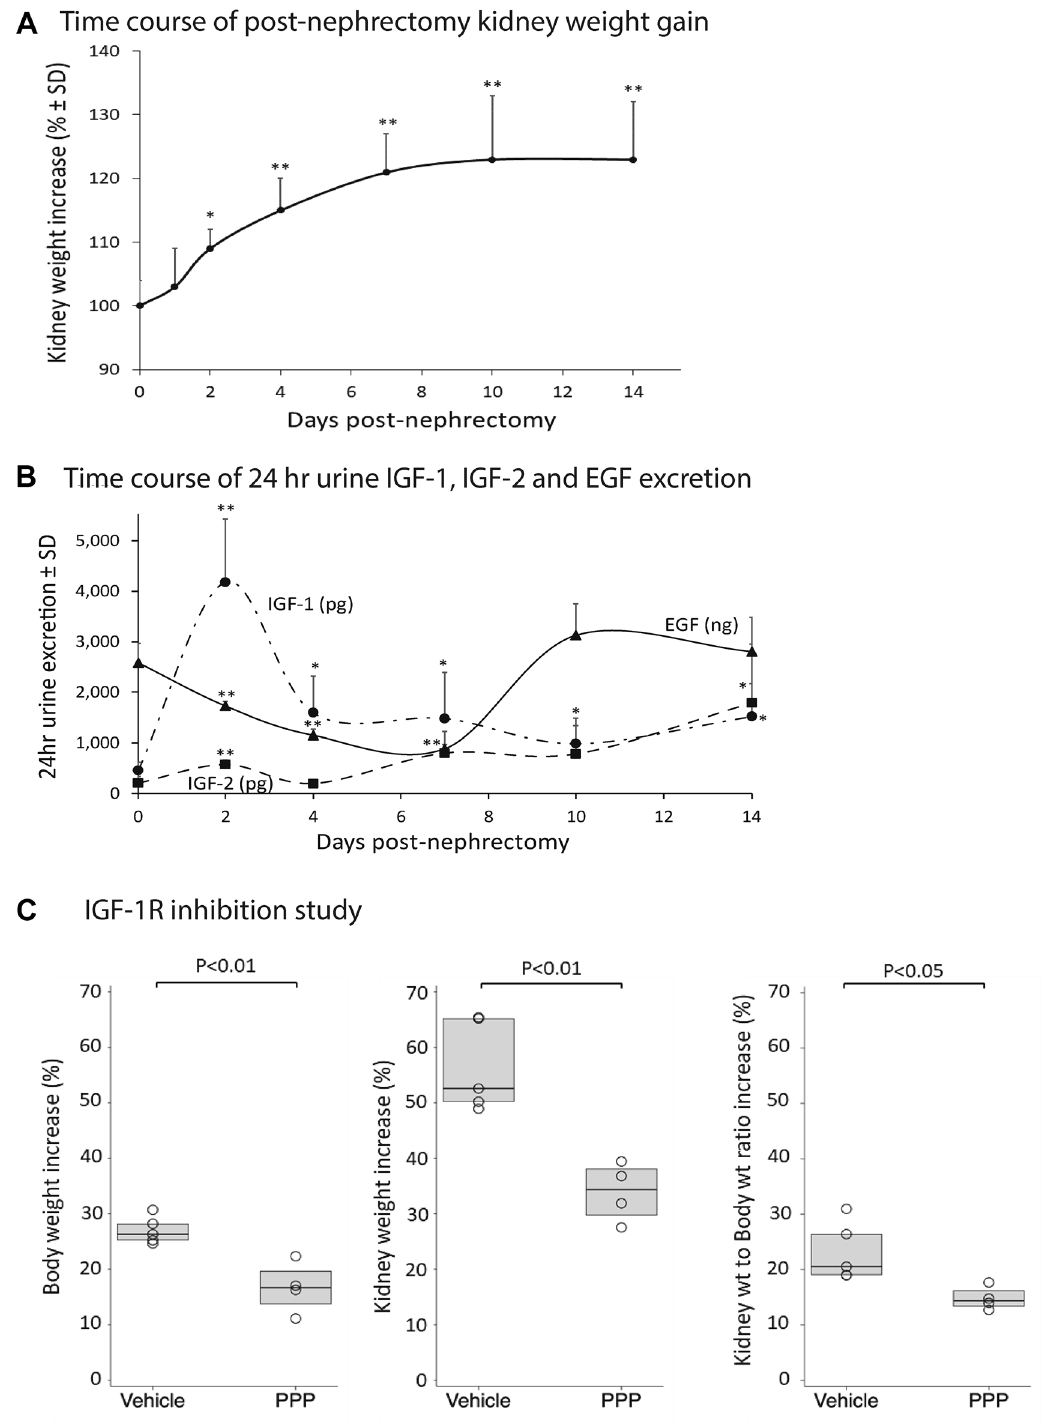
Figure 3. Short-term uni-nephrectomy studies. Panel ( A ) Rapid weight gain of the remaining kidney following uni-nephrectomy in 300 g rats. The kidney growth rate is maximal by 2 days post-uni-nephrectomy and completed by 8-10 days post-uni-nephrectomy (n = 5 per group). * P < 0.05, ** P < 0.01 compared to the baseline value. Panel ( B ) Time-course of urine IGF-1, IGF-2, and EGF excretion after uni-Nx. Urine IGF-1 peaks 8-fold above baseline by day-2 post-uni-Nx and remain significantly increased for 14-days. Urine IGF-2 increases 2-fold by day-2 post-uni-Nx but is increased 10-fold by day-14 post-uni-Nx. Urine EGF decreases after uni-Nx but returns to baseline by day-14 post-uni-Nx. Panel ( C ) IGF-1R inhibitor study. The IGF-1R inhibitor picropodophyllin (PPP) was compared to vehicle-injected IP 12 hourly and started 1 day before uni-Nx of 100 g rats and continued for 8-days. PPP reduced body weight gain (left panel), kidney weight gain (middle panel), and kidney weight/body ratio (right panel). The error bars are 1SD. * P < 0.05, ** P <